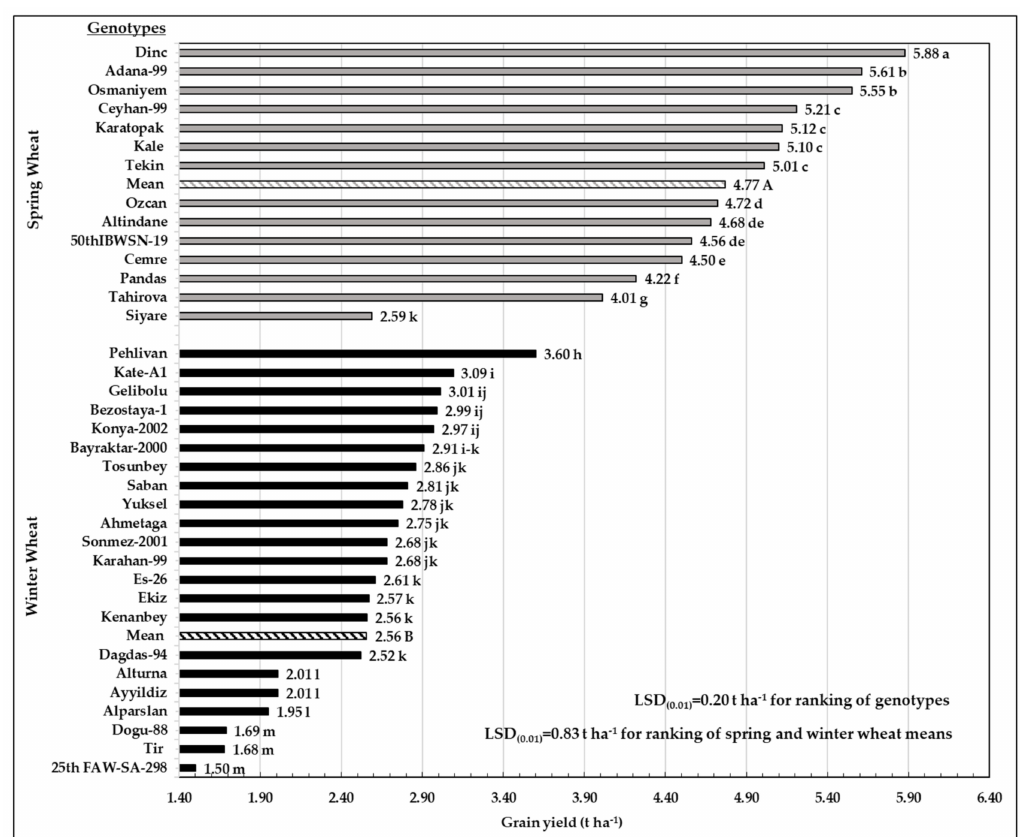
Figure 3. Comparing winter wheat genotypes with spring wheat genotypes for grain yield (t ha − 1 ) over two cropping seasons. Genotypes with the same letter are not significantly